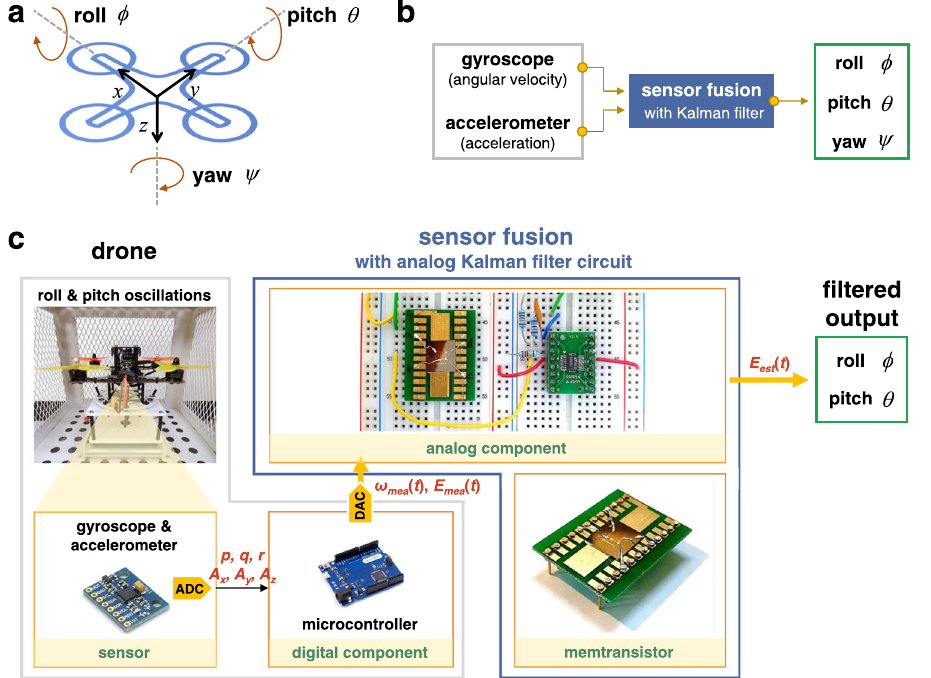
Fig. 1 Overview of memtransistor-based analog – digital hybrid computing platform. a The inertial frame of the drone. b The Euler angle estimation procedure through the sensor fusion with Kalman fi lter algorithm. c Schematic illustration of our analog – digital hybrid computing platform. The analog component, i.e., memristor-based analog circuit, is responsible for executing the Kalman fi ltering algorithm. The digital component, i.e., microcontroller, contributes to the data collection from the sensor module, and signal generation through the